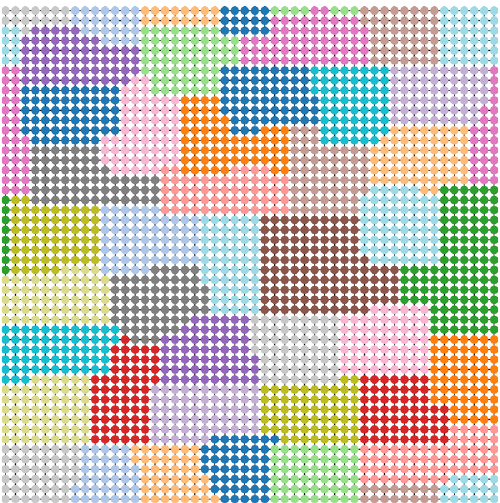
Figure 10. Graph partitioning using Metis. Each node represents a component of the Hamiltonian coefficient matrix J in Eq. (10), and the color of each node indicates the group to which the component belongs. (The data obtained using Metis 5.1.0 are plotted with software